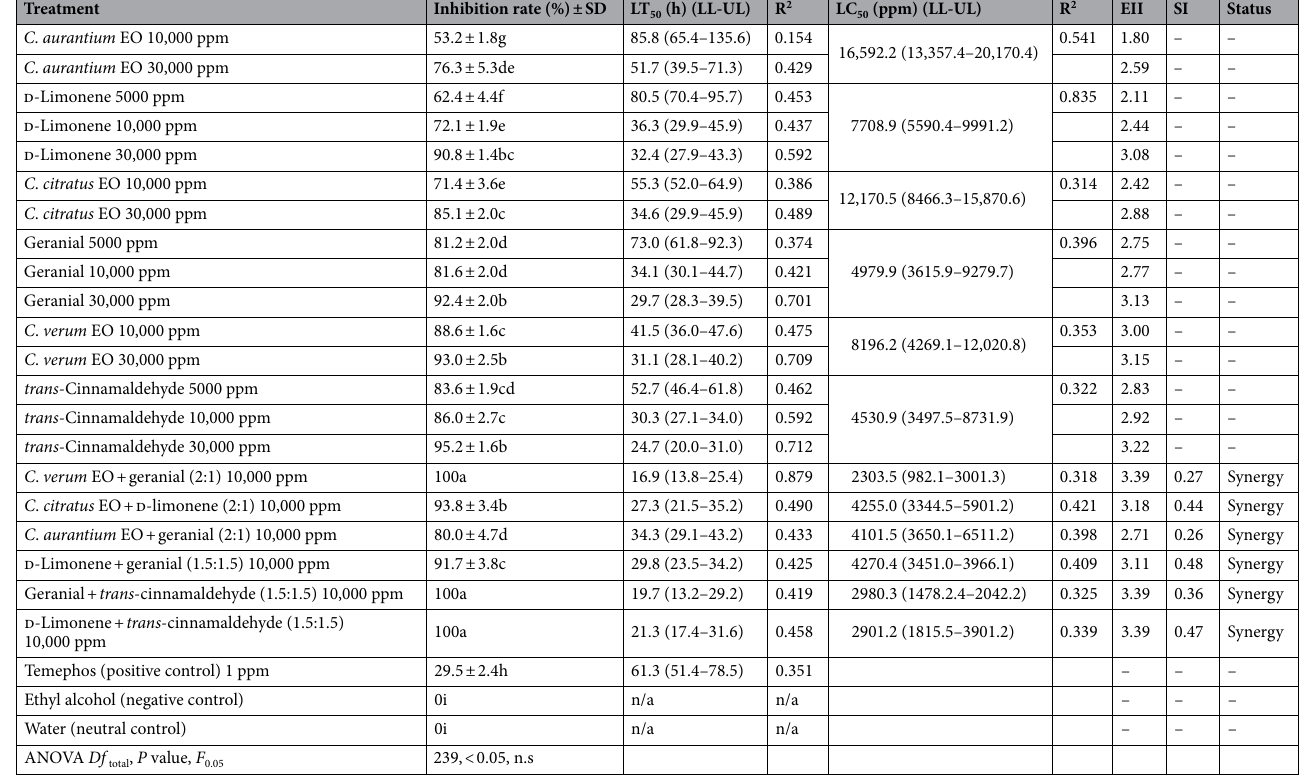
Table 3. Ovicidal effects of EO formulations from Cinnamomum verum , Citrus aurantium , and Cymbopogon citratus EOs and their major constituents and combined formulations on the hatching rate of Aedes albopictus eggs after 48 h of incubation. Means percentage ovicidal activities in each column followed by same letters are not significantly different by ANOVA at P < 0.05. LT 50 Lethal time that kills 50% of the exposed eggs, LC 50 lethal concentration that kills 50% of the exposed organisms, LL 95% lower confidence limit and UL , 95% upper confidence limit, R 2 regression coefficient, EII effective inhibition rate index, n.s. not significantly different at P < 0.05; SI synergistic index, n/a not